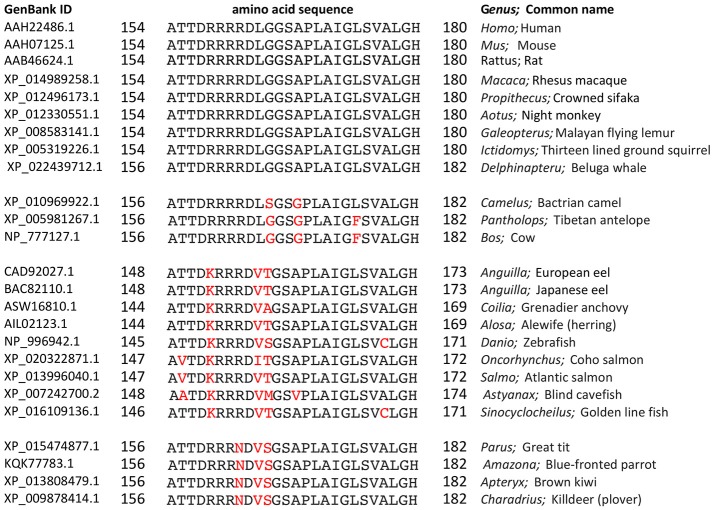
Amino acid sequence alignment for the loop D and flanking domains of AQP1 channels from diverse classes of vertebrates (mammals, fish, and birds). Amino acid sequences downloaded from the National Center for Biotechnology Information (NCBI) Protein database (www.ncbi.nlm.nih.gov/protein) were aligned using the NCBI BlastP online application (blast.ncbi.nlm.nih.gov) for multiple sequences. Residues in black are identical with the query sequence Homo sapiens AQP1. Variations in sequence are highlighted in red.